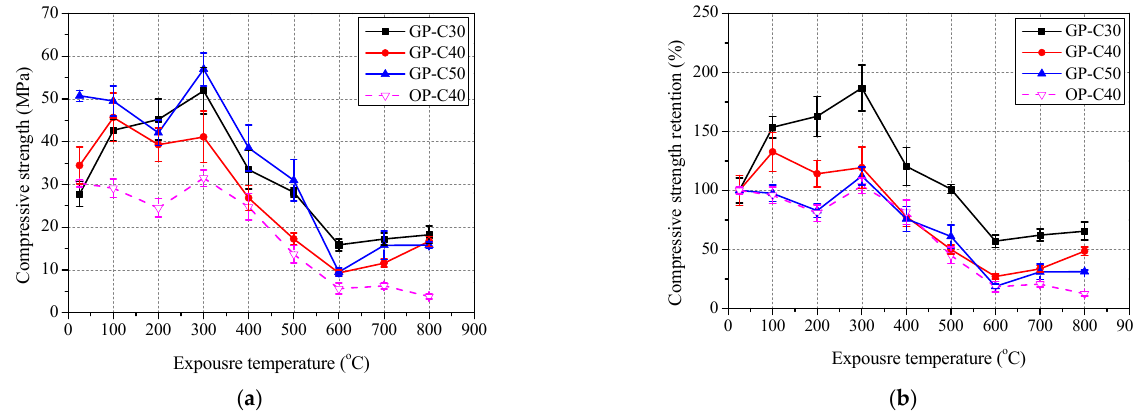
Figure 12. Residual compressive strength of paste after exposure to elevated temperature: ( a ) compressive strength and ( b ) retention.